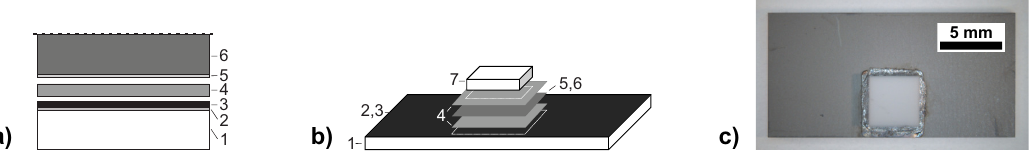
Figure 1. ( a ) schematic cross-section of the initial joining-zone configuration (lower half; symmetric joint), and ( b ) layout of the shear-test samples; with 1: lower substrate, 2: Ti-W adhesion layer (optional), 3: Ni metallisation layer, 4: Sn solder foil or plated layer, 5: Ag-Cu-In protective layer, 6: Ni(V)-Al reactive foil, 7: upper substrate (including metallisation layers). In case of Cu as substrate material, no adhesion layer is necessary and the Sn layer is directly plated onto the Ni metallisation of the substrate; ( c ) photograph of a reactively joined Al 2 O 3 -specimen for shear testing (grey: Ni surface